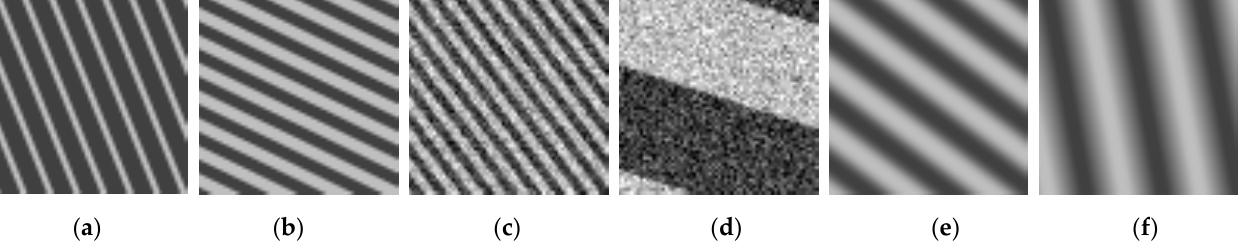
Figure 4. Instances of synthetic texture images. The directionality is reported with respect to vertical direction. ( a ) Bar thickness 2, bar period 8, directionality 22°, no perturbation; ( b ) bar thickness 4, bar period 8, directionality 64°, no perturbation; ( c ) bar thickness 3, bar period 6, directionality 37°, Gaussian noise with std equal 6000; ( d ) bar thickness 32, bar period 64, directionality 72°, Gaussian noise with std equal 8000; ( e ) bar thickness 8, bar period 16, directionality 53°, averaging blur with kernel 5 × 5; ( f ) bar thickness 12, bar period 24, directionality 11°, averaging blur with kernel 9 × 9.